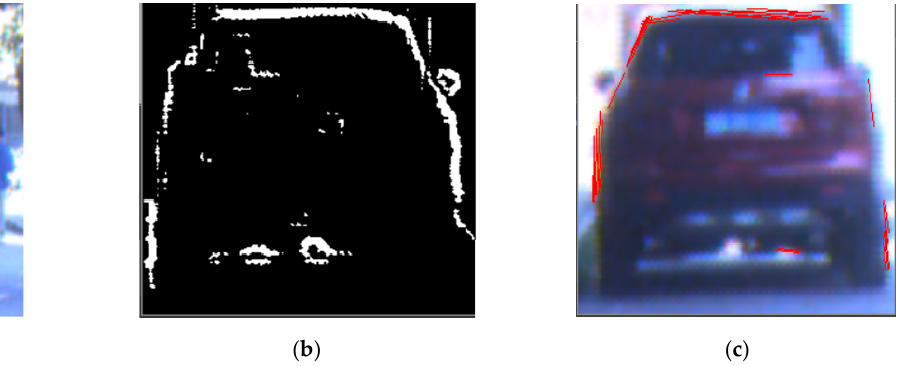
Figure 11. Vehicle contour fitting. ( a ) Radar recognition area. ( b ) Binary image of vehicle contour edge. ( c ) Hough transform to fit vehicle contour.